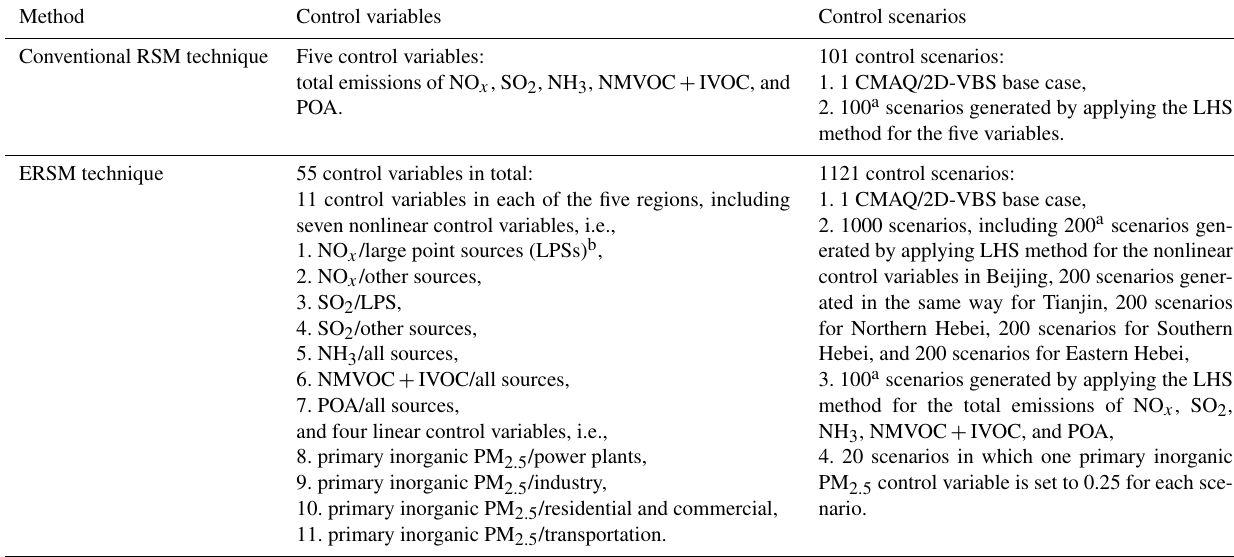
Table 1. Description of the RSM/ERSM prediction systems developed in this study.